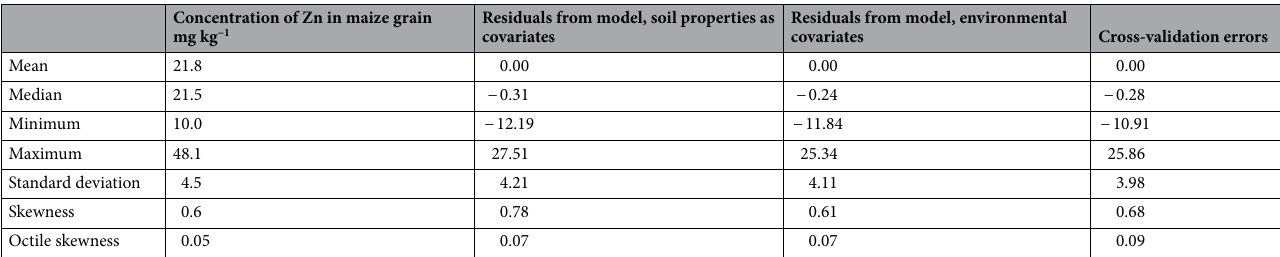
Table 1. Summary statistics of Zn concentration in grain (n = 1600), of residuals from fitted exploratory saturated models and cross-validation errors for the E-BLUP with easting and downscales mean annual temperature as fixed